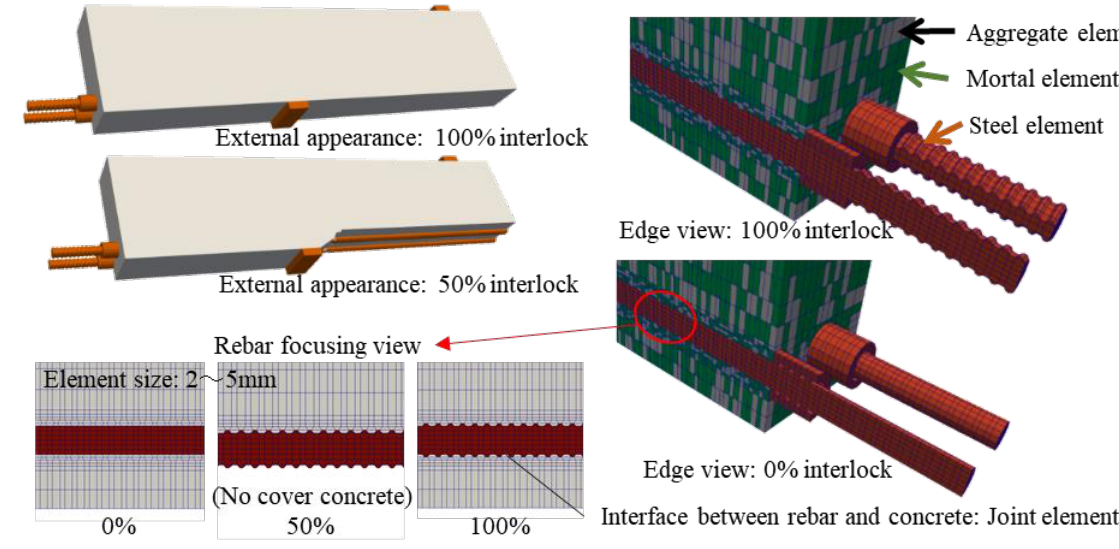
Figure 7. Outline of analysis